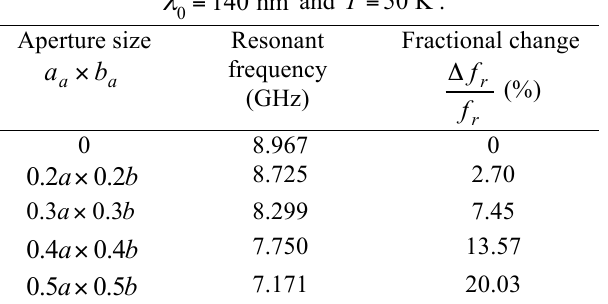
Table 2: Resonant frequencies of superconducting rectangular microstrip patch over ground planes with and without rectangular apertures; cm1cm5.1 × = × ba